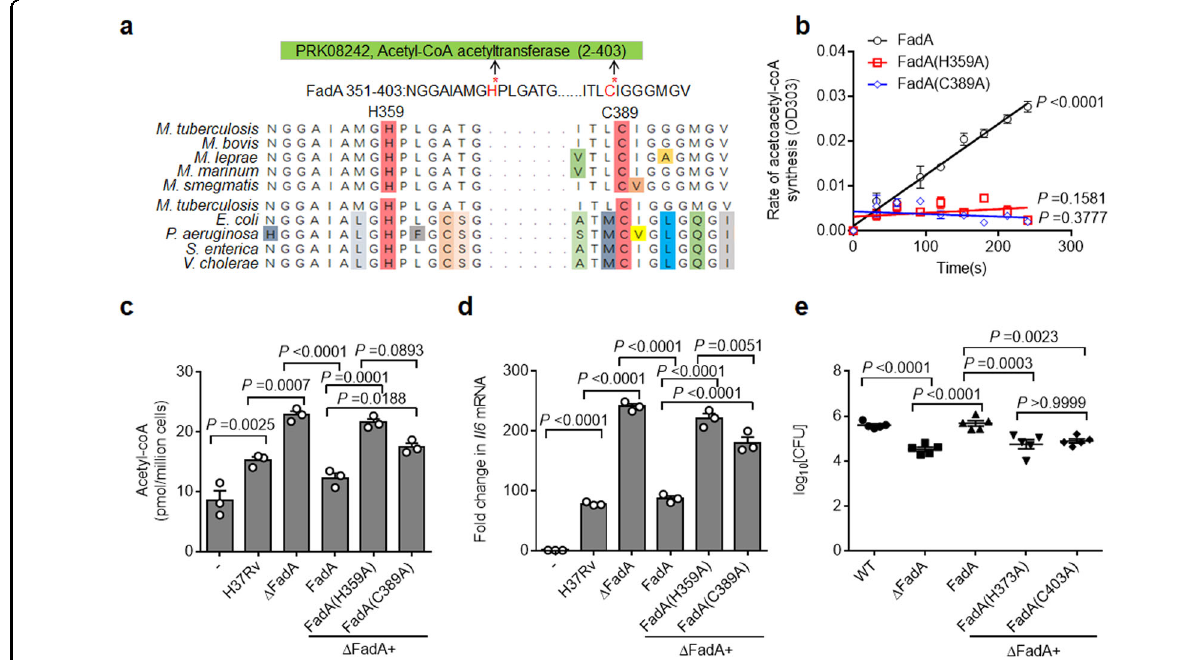
Fig. 6 FadA functions through its acetyltransferase activity. a Alignment of H359 and C389 sites of FadA in mycobacteria and bacteria. b In vitro two-substrate steady-state kinetic assay of acetyltransferase activity of recombinant FadA and FadA-Mut (FadA(H359A), FadA(C389A)) protein. c Assay of the acetyl-CoA level of peritoneal macrophages infected with H37Rv, H37Rv Δ FadA, H37Rv( Δ FadA + FadA), H37Rv( Δ FadA + FadA(H359A)), and H37Rv( Δ FadA + FadA(C389A)) strains for 4 h (MOI = 1) (mean ± SEM). d qPCR analysis of Il6 mRNA of peritoneal macrophages infected with H37Rv, H37Rv Δ FadA, H37Rv( Δ FadA + FadA), H37Rv( Δ FadA + FadA(H359A)), and H37Rv( Δ FadA + FadA(C389A)) strains for 4 h (MOI = 1) (mean ± SEM). e Adult zebra fi sh were intraperitoneally infected with roughly 200 CFU of WT, Δ FadA, Δ FadA + FadA, Δ FadA + FadA(H373A), and Δ FadA + FadA (C403A) M. marinum strains for 14 days. Histopathology was assessed in the whole fi sh by bacterial titers (mean± SEM of n = 5 fi sh infected for 14 days). Total number of zebra fi sh analyzed: fi ve (WT), fi ve ( Δ FadA), fi ve ( Δ FadA + FadA), fi ve ( Δ FadA + FadA(H373A)), fi ve ( Δ FadA + FadA(C403A)). Data in b – e represent one experiment with at least three independent replicates. One-way ANOVA with Bonferroni ’ s multiple comparisons test ( c – e ) was used for statistical